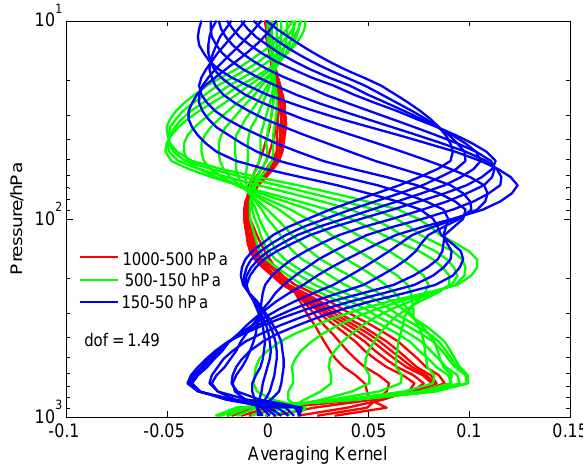
Figure 1: Averaging kernels of TES signals in a two-day global survey (on June 30th and July 1st, 2007). Fig. 1. Averaging kernels of TES signals in a two-day global survey (on 30 June and 1 July